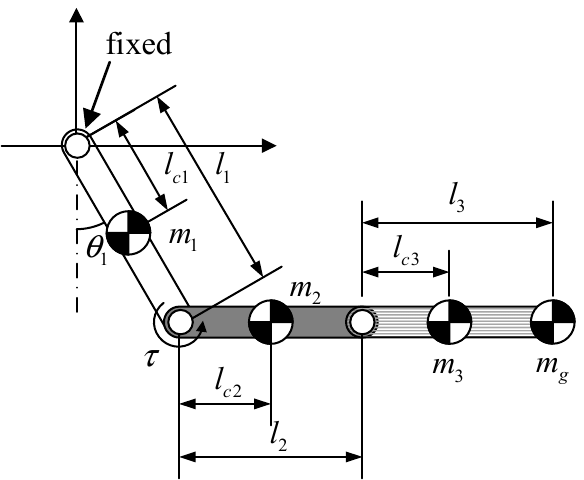
Figure 5. Design parameters with the robot modeled as a three-link system.